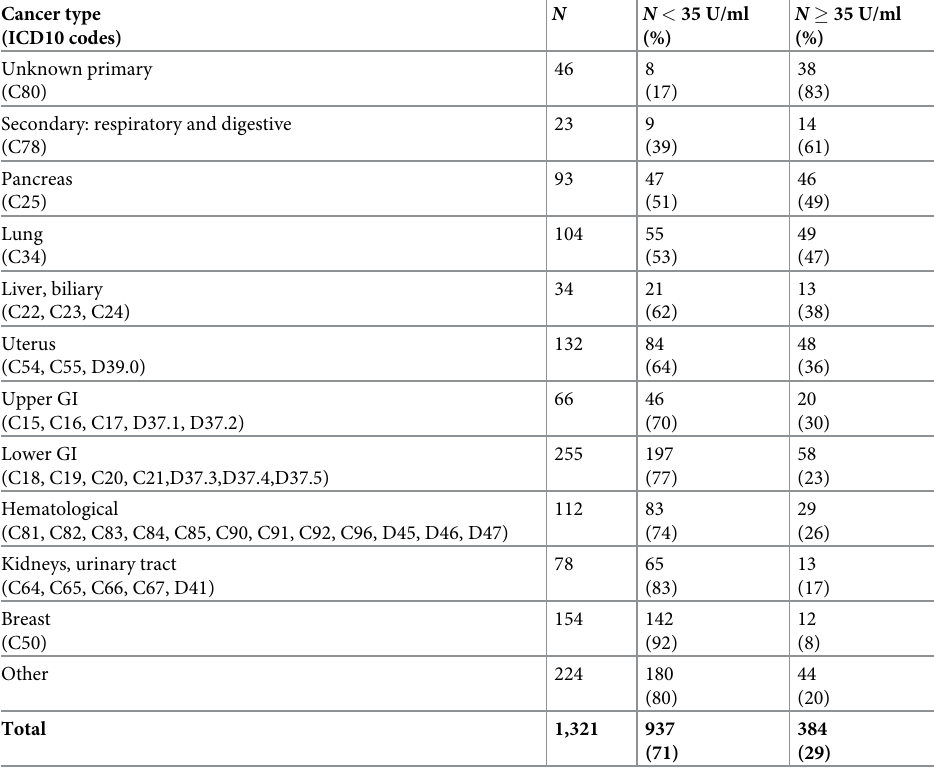
Table 4. Cancers diagnosed in women without ovarian